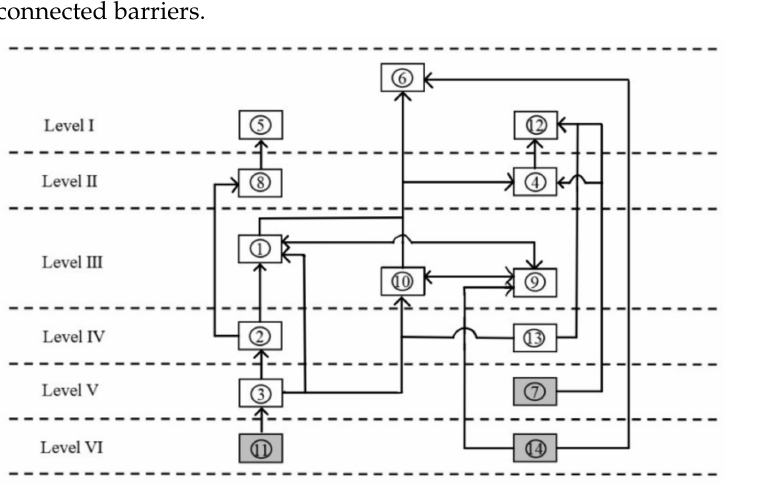
Figure 1. Result of the